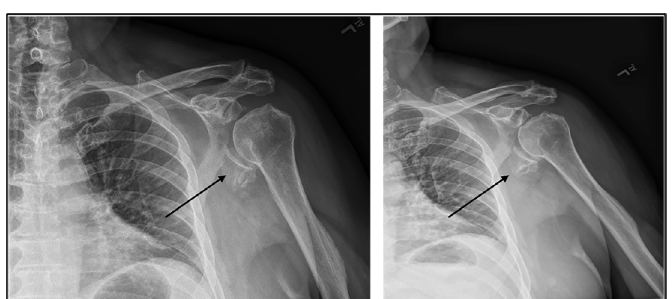
Image 1. Anteroposterior (left) and oblique (right) views of the left shoulder plain radiograph, showing the inferior rim of the fractured glenoid with extension through the body displaced inferiorly (arrows). Based on the Ideberg classification system of glenoid fractures, this fracture pattern is type